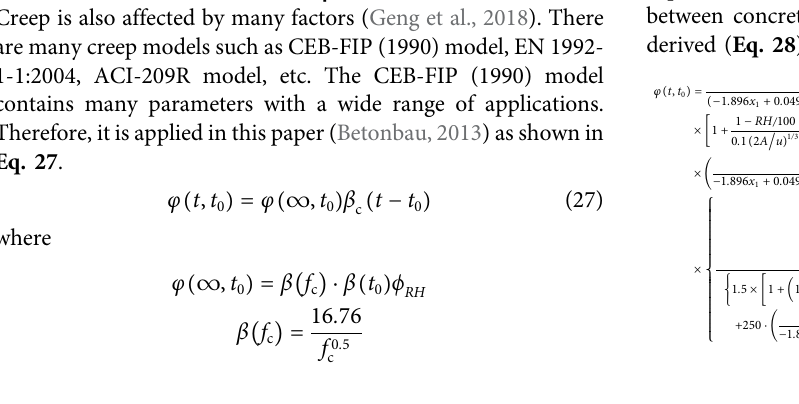
TABLE 6 | Experimental value and predicted value of concrete properties at the age of 3 and 7 days. No Tensile strength (MPa) Elastic modulus